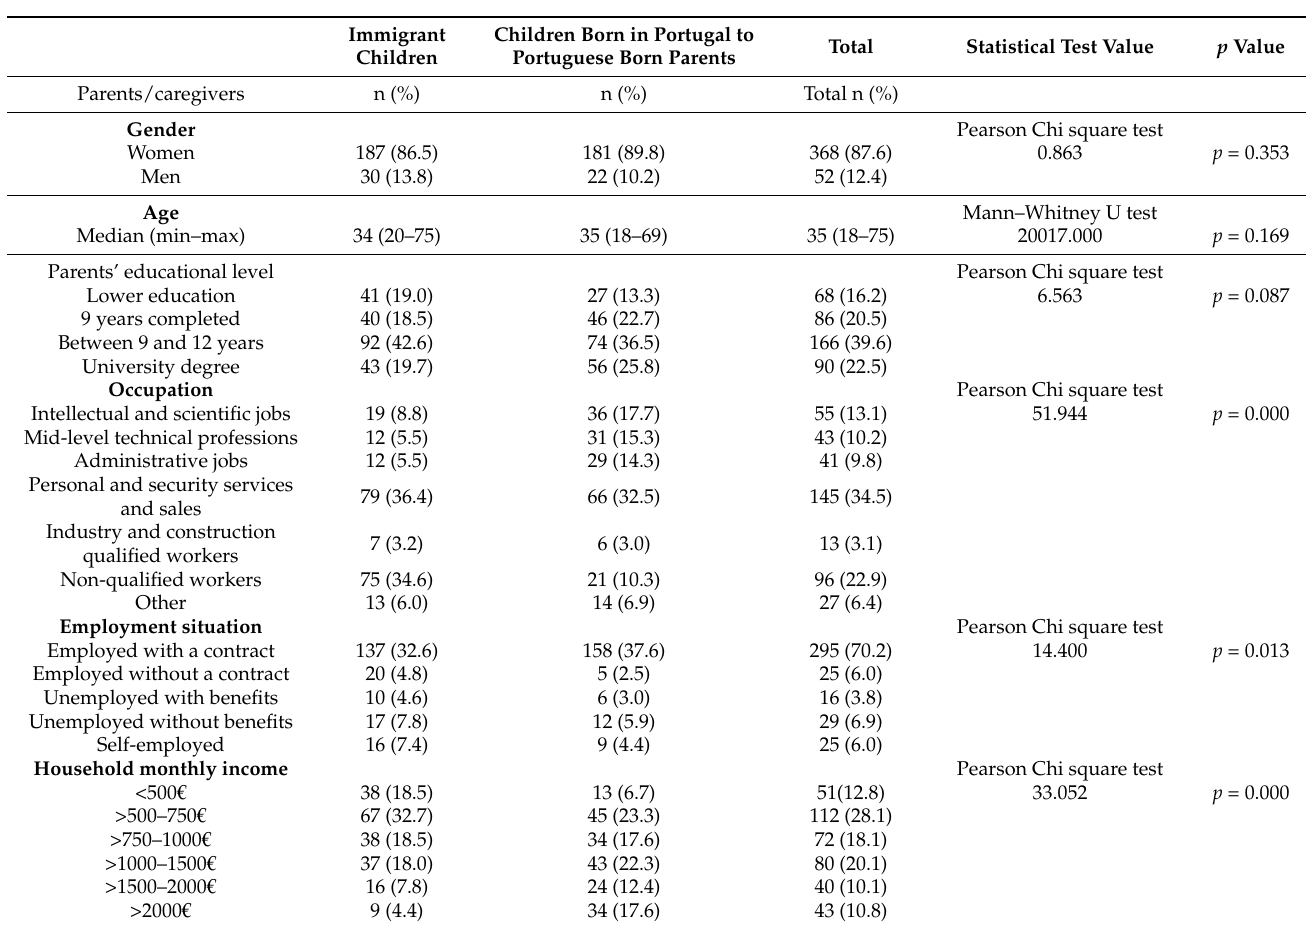
Table 3. Sociodemographic characteristics of